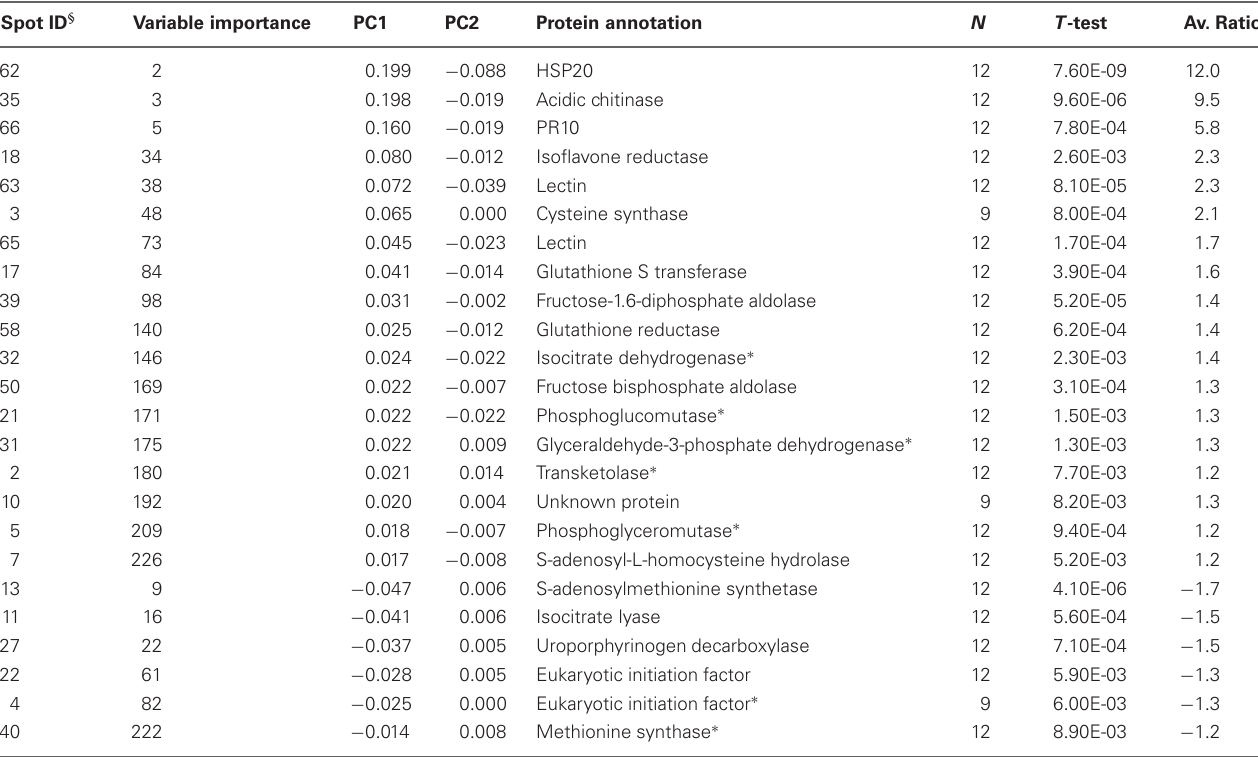
Table 1 | Overview of the identified